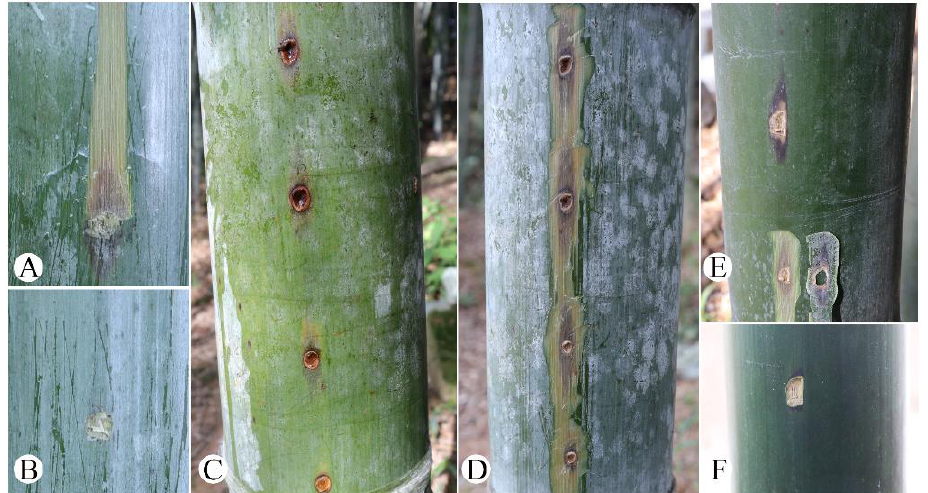
Figure 2. Pathogenicity test. ( A ) Symptoms on Moso bamboo culm inoculated with the isolate BBB1 after 10 days; ( B ) Control Moso bamboo culm inoculated with PDA plug; ( C ) Symptoms on 5-year-old Moso bamboo inoculated with the isolate BBB1 after 4 months, the upper three wounds inoculated with the isolate BBB1, and the lower one with PDA plug; ( D ) Details under the diseased tissues; ( E ) Symptoms on 1-year-old Moso bamboo inoculated with the isolate BBB1 after 14 days; ( F ) 1-year-old control Moso bamboo inoculated with PDA plug.